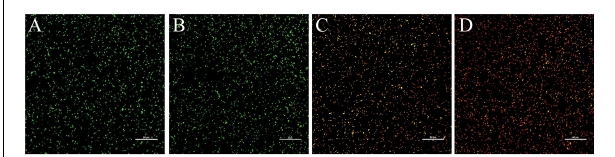
FIGURE 5 | Confocal laser scanning microscope images of L. monocytogenes . Untreated bacterial cells incubated for 90 min (A) or 150 min (B) , and bacterial cells treated with LED illumination for 90 min (C) or 150 min (D) were visualized under the confocal laser scanning microscope.